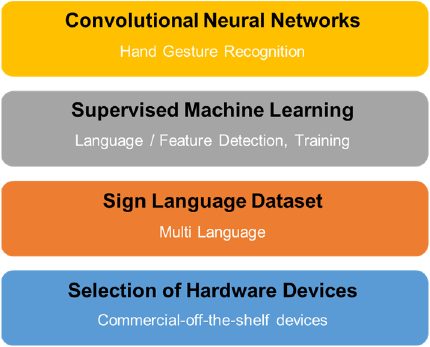
Figure 1. Research scope.